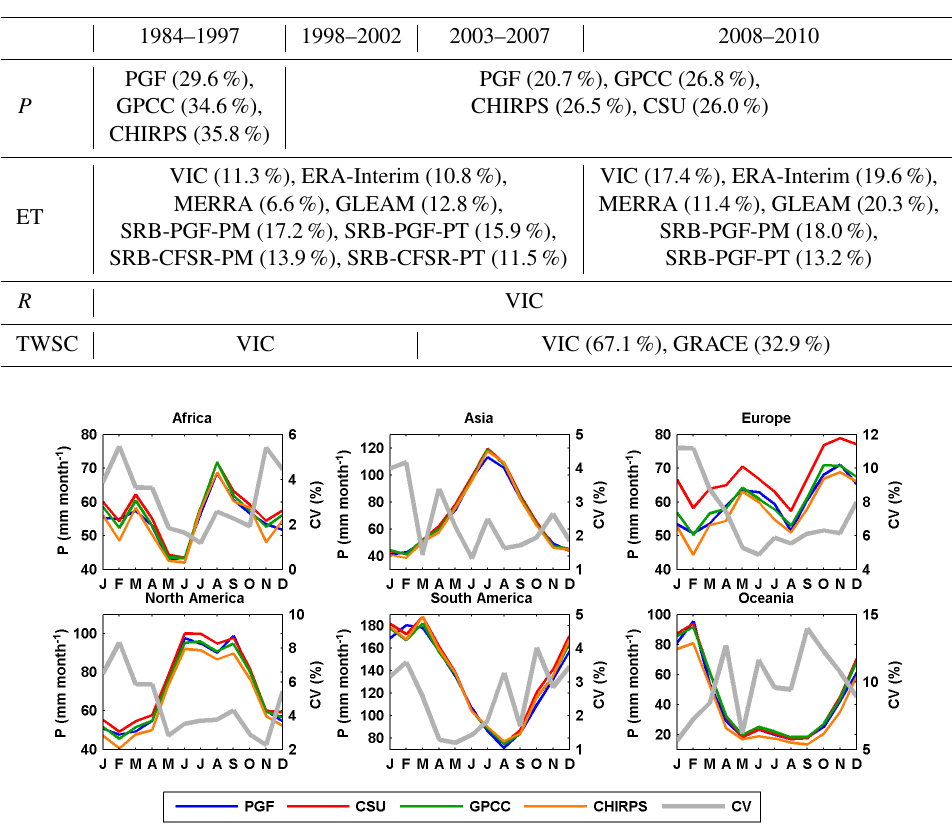
Figure 2. Seasonal cycles of precipitation from different products over the six continents for 1998–2010 (CHIRPS and CSU only cover the region between 50 ◦ N and 50 ◦ S); therefore, only the grids between 50 ◦ N and 50 ◦ S are counted in the calculation of the seasonal cycle; the coefficient of variance (CV, %) is calculated as the standard deviation divided by the ensemble mean of all the products (the same for Figs.